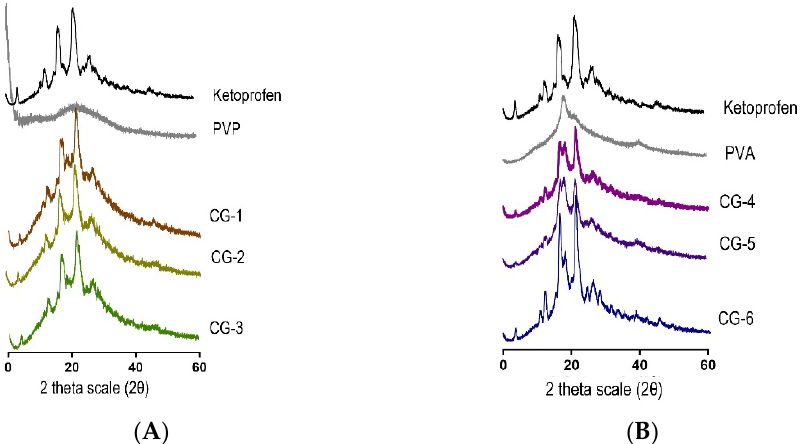
Figure 5. ( A ) Co-grinded Ketoprofen Diffractogram with PVP; ( B ) Co-grinded Ketoprofen Diffrac- togram with PVA.